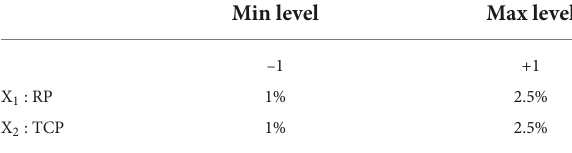
TABLE 1 Factors’ levels (X1 and X2) involved in P